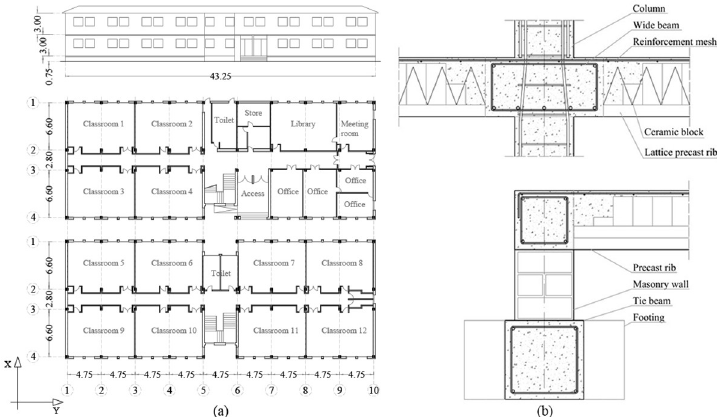
Fig 3. School’s distribution in plan and fac¸ade (dimensions in metres) (a) and design details (b): column-wide beam joint reinforcement detailing (superior) and insulating suspended ground floor (inferior).